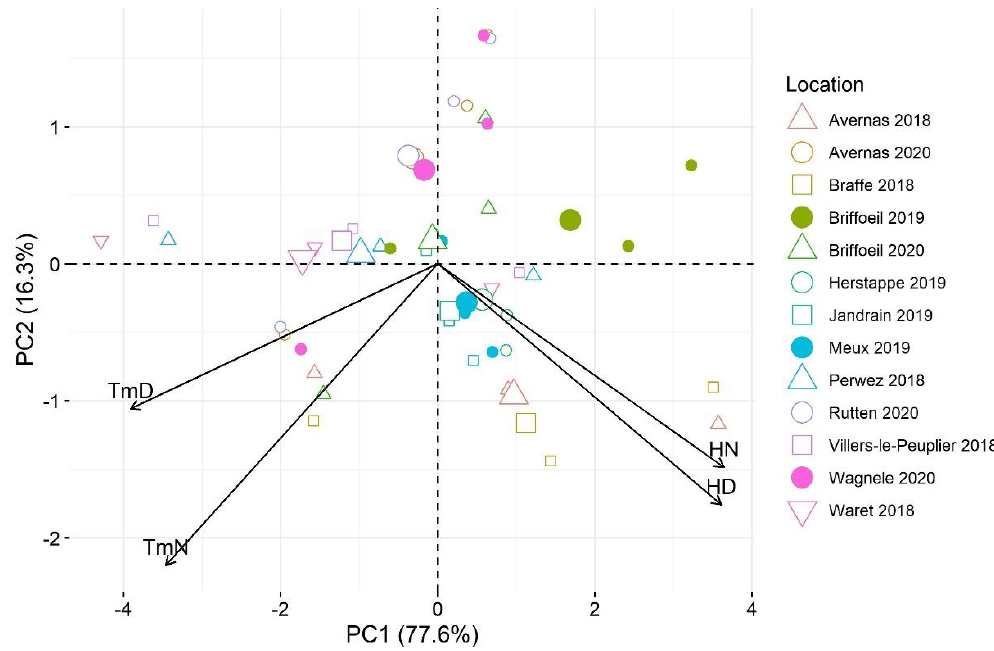
Figure 3. Biplot of the first two axes of the principal component analysis summarizing the relation- ships between climate variables and sugar beet/Cercospora leaf spot experimental sites during the June-August period of 2018–2020. TmD: mean temperature during daytime, TmN: mean temperature during nighttime; HD: mean relative humidity during daytime; and HN: mean relative humidity during nighttime. Daytime and nighttime were defined as the periods between 7.00 a.m. to 8.59 p.m. and between 9.00 p.m. to 6.59 a.m. the following day, respectively. Disease incidence data were partitioned into testing (61%, n = 8 sites) and validation (39%, n = 5 sites) sets, and were used in an independent manner for evaluation/selection and validation purposes, respectively (Table 3). All sites were randomly chosen from the two groups observed through the PCA. Table 3. List of sugar beet/Cercospora leaf spot experimental sites selected for model calibration and validation. Sites were randomly selected based on the principal component analysis.